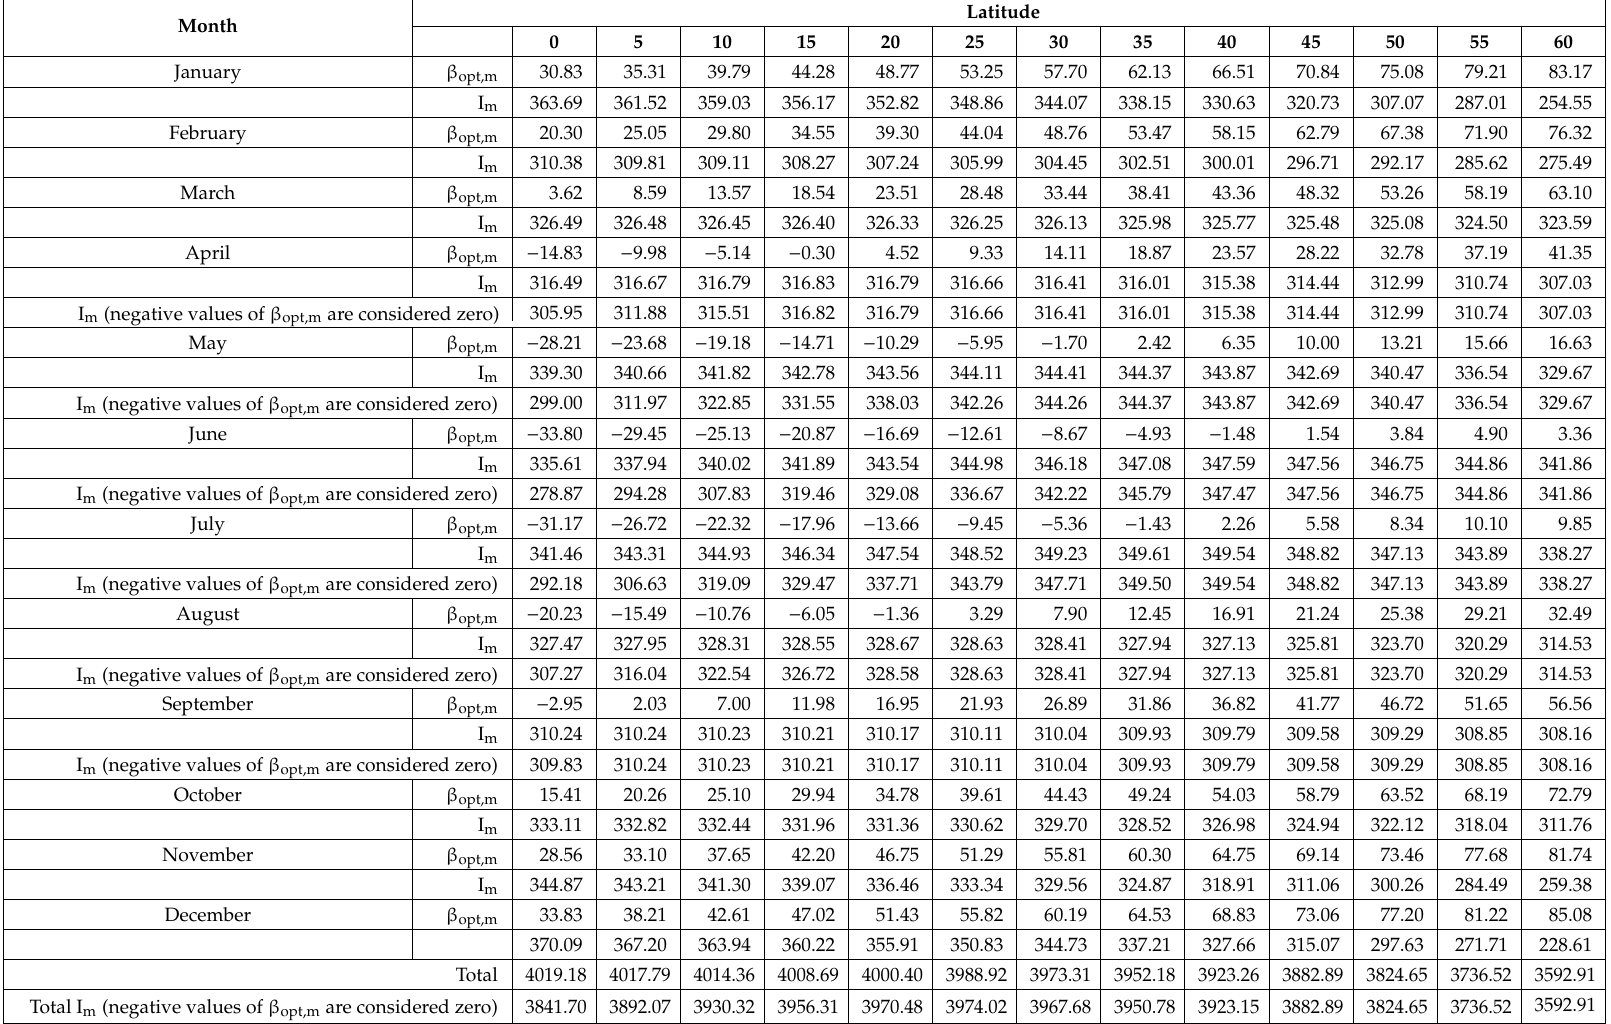
Table 4. The monthly optimum tilt angle β opt,m and extraterrestrial radiation I m in kWh / m 2 for di ff erent